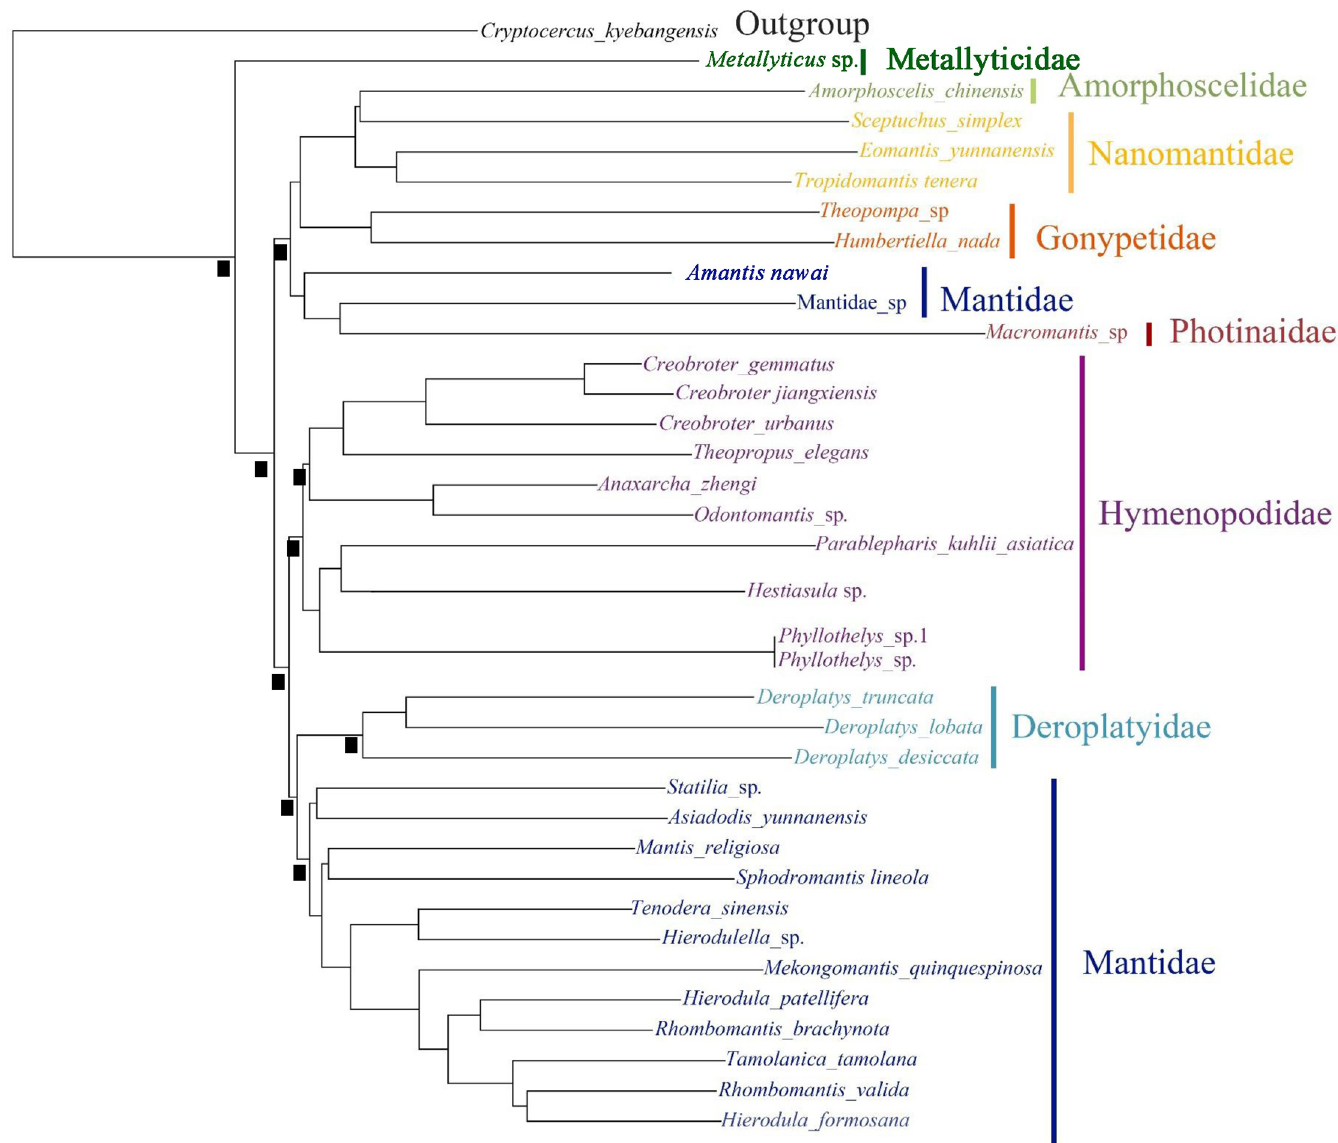
Fig 7. Phylogenetic relationships of the Mantodea inferred from mitochondrial genome. The black square implies that ML bootstrap support values and Bayesian posterior probabilities in percentages are greater than 90.